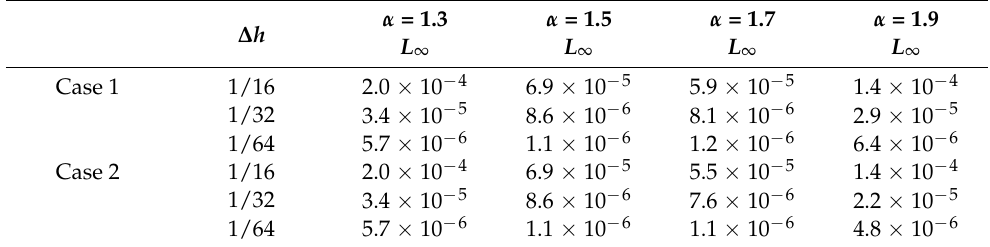
Table 7. Error norms of the wavelet solution at t = 1 with various spatial grid sizes for Example 6. ∆ h α = 1.3 α =